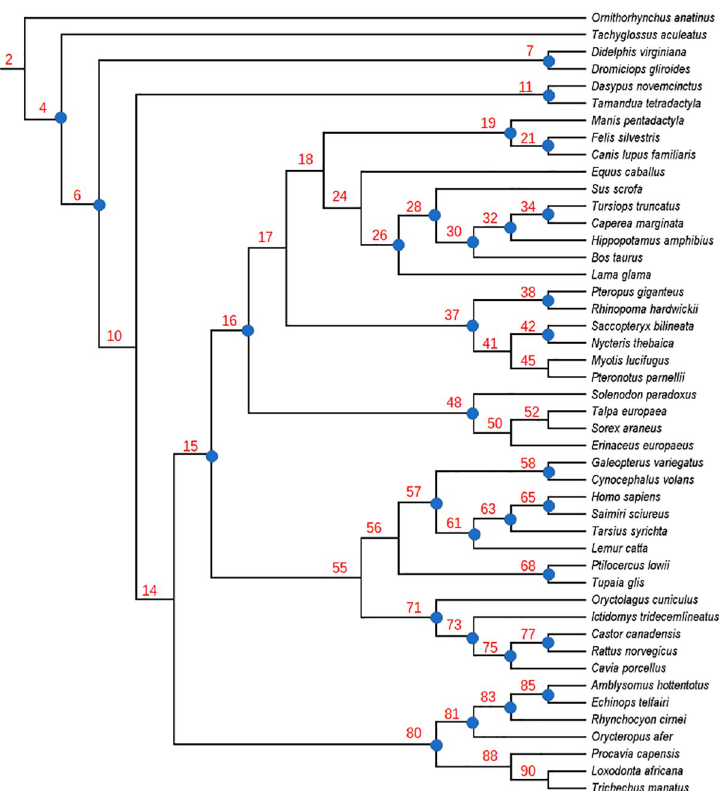
Fig 1. Molecular scaffold species tree. Our fully bifurcating molecular scaffold species tree (20588 steps) that was used for ancestral state reconstructions. The tree was rooted with the monotreme Ornithorhynchus anatinus (platypus). Each internal node has a designated number in red. This number corresponds with the number assigned to each hypothetical predicted ancestor (HPA) in our matrices. These matrices are available in figshare (10.6084/m9. figshare.15183258). Internal nodes that were constrained in the molecular scaffold are denoted with blue circles.